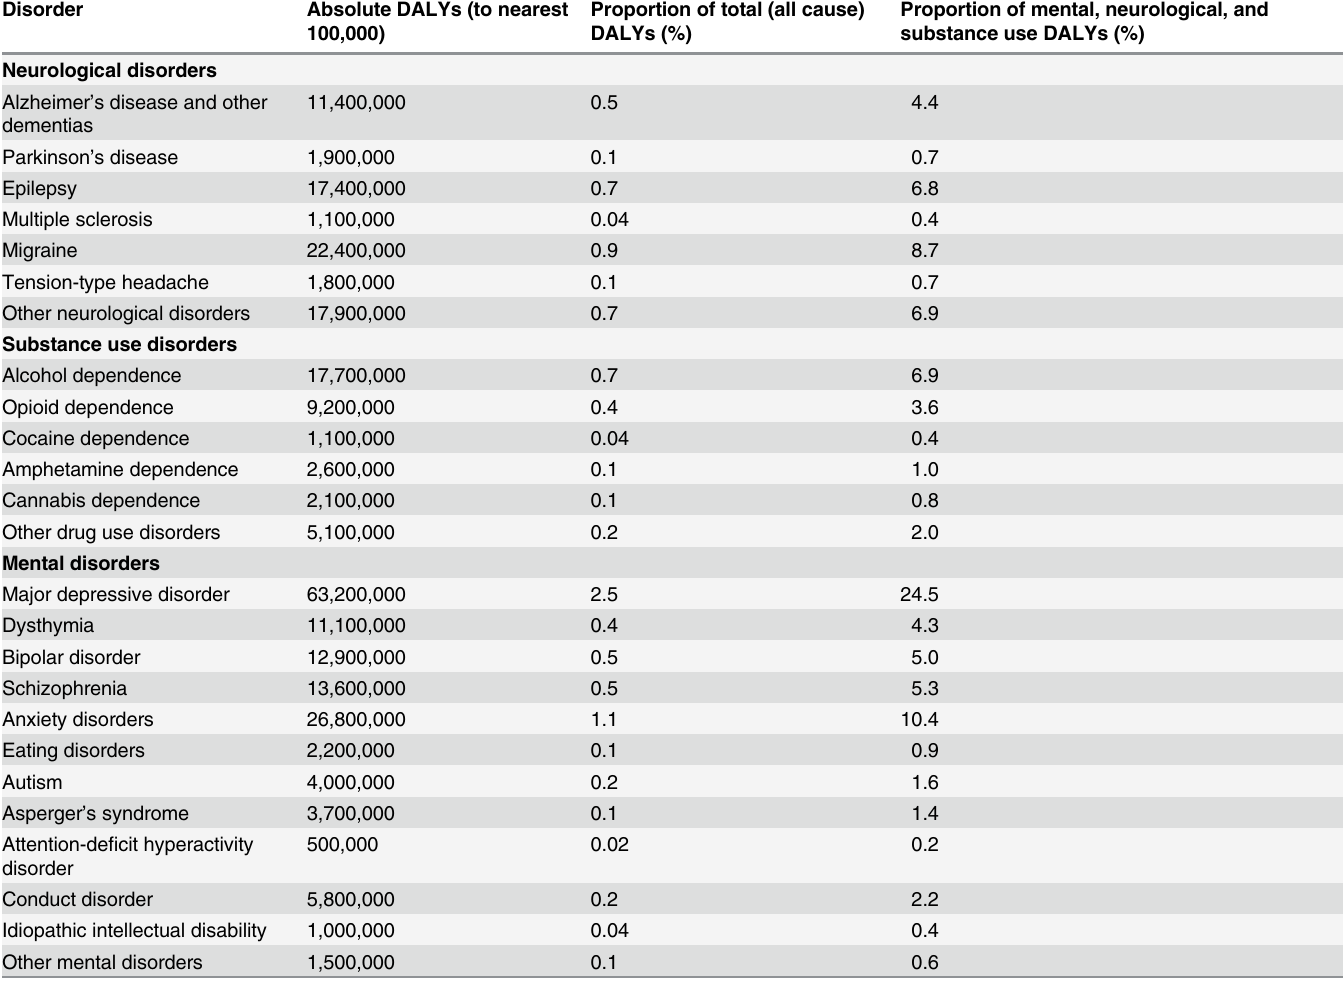
Table 3. DALYs (absolute numbers, and proportions) attributable to mental, neurological and substance use disorders in